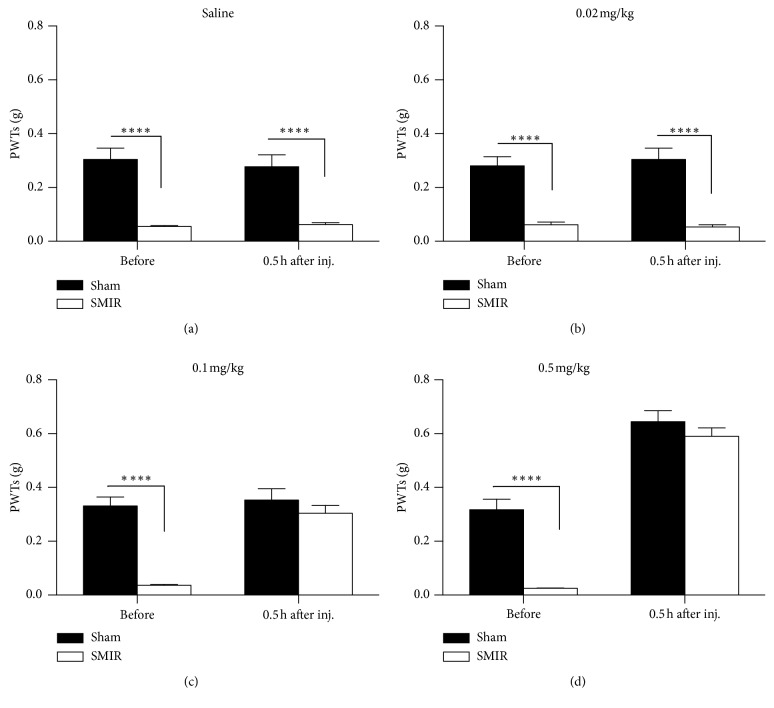
Systemic administration of clonidine raised the paw withdrawal threshold (PWT) in skin/muscle incision and retraction (SMIR) mice. (a) Saline had no effect on the PWTs in the sham and SMIR groups injected at day 4 after SMIR (two-way RM ANOVA, sham versus SMIR: F1; 17 = 35.83, P < 0.0001; treatments: F1; 17 = 0.55, P=0.47, interaction: F1; 17 = 1.74, P=0.20; n = 7 for the sham group, n = 8 for the SMIR group, ∗∗∗∗P < 0.0001 under Sidak's multiple comparisons test). (b) SMIR decreased the PWTs, which was not changed by the application of clonidine at 0.02 mg/kg (two-way RM ANOVA, sham versus SMIR: F1; 17 = 87.23, P < 0.0001; treatments: F1; 17 = 0.08, P=0.78, interaction: F1; 17 = 0.33, P=0.57; n = 9 for the sham group, n = 10 for the SMIR group, ∗∗∗∗P < 0.0001 under Sidak's multiple comparisons test). (c) Clonidine at 0.1 mg/kg increased the PWTs of the SMIR group (two-way RM ANOVA, sham versus SMIR: F1; 17 = 24.07, P=0.0001; treatments: F1; 17 = 37.01, P < 0.0001, interaction: F1; 17 = 26.54, P < 0.0001; n = 9 for the sham group, n = 10 for the SMIR group, ∗∗∗∗P < 0.0001 under Sidak's multiple comparisons test). (d) Clonidine at 0.5 mg/kg increased the PWTs of both the SMIR group and the sham group (two-way RM ANOVA, sham versus SMIR: F1; 17 = 24.04, P=0.0001; treatments: F1; 17 = 273.3, P < 0.0001, interaction: F1; 17 = 19.53, P < 0.0004; n = 9 for the sham group, n = 10 for the SMIR group, ∗∗∗∗P < 0.0001 under Sidak's multiple comparisons test). ANOVA, analysis of variance; RM, repeated measures.